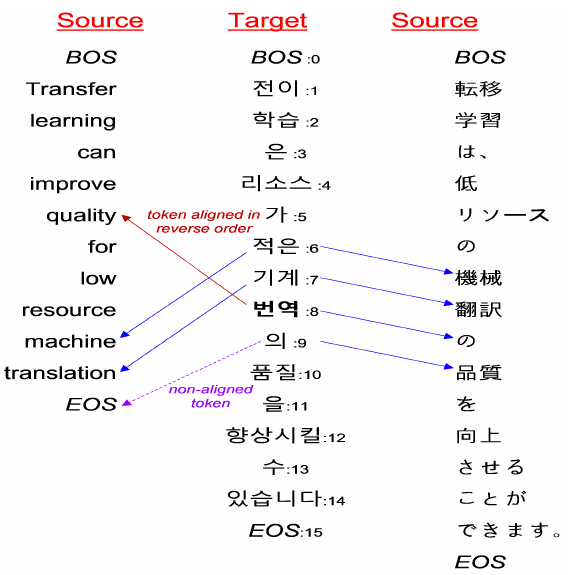
Figure 2. The examples of cross-attentions between English–Korean and Japanese–Korean.